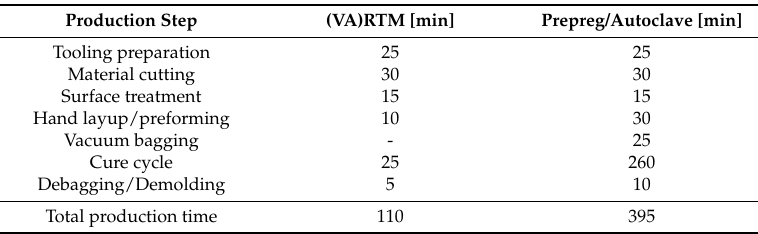
Table 1. Comparison of processing times for FML plates at laboratory scale for (VA)RTM and prepreg/autoclave technique considering corona surface treatment method [10].